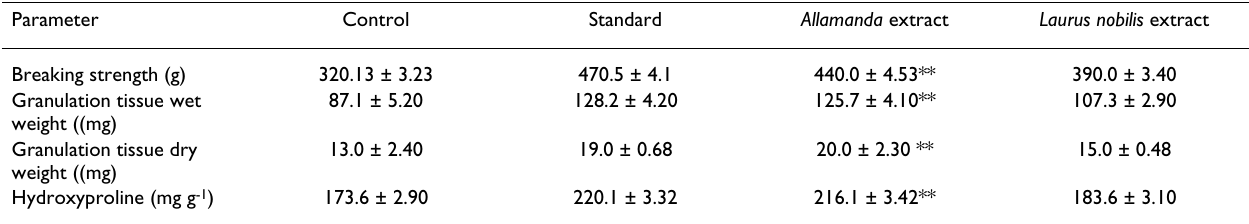
Table 2: Effects of topical application of Allamanda cathartica and Laurus nobilis in incision wound model